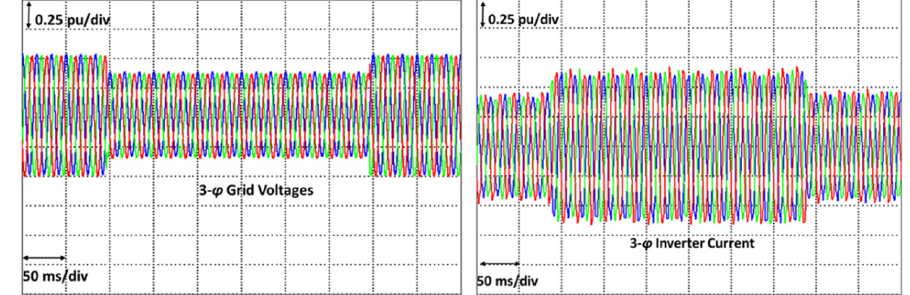
Figure 18. Grid Voltages and Inverter current under Symmetrical grid fault.